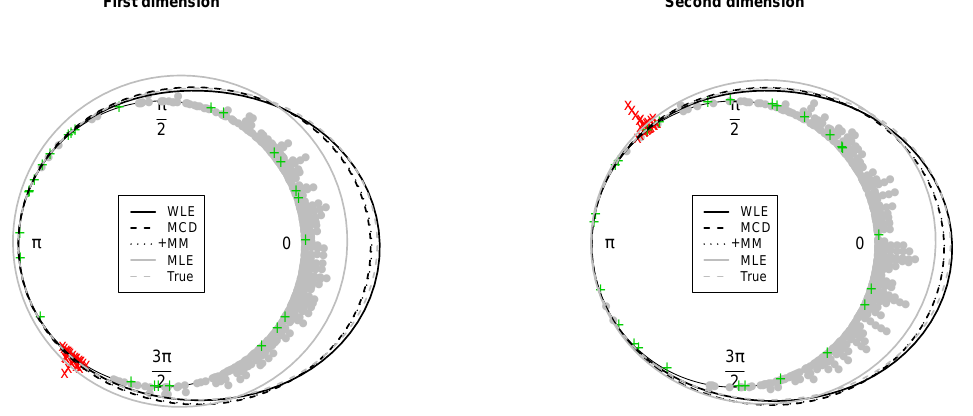
Figure 4. Second synthetic example. Fitted and true marginal distributions on the unit